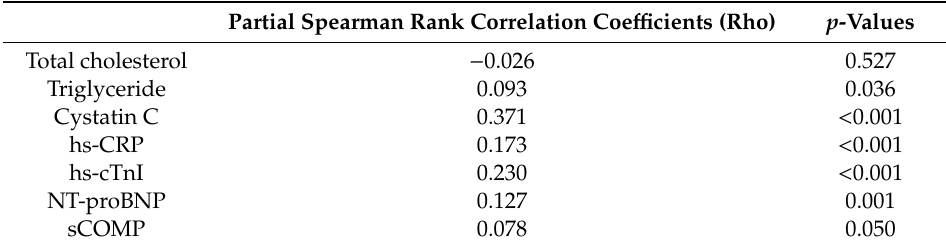
Table 2. Correlation between GDF-15 and several biochemical parameters, adjusted for age and sex. Partial Spearman Rank Correlation Coe ffi cients (Rho) p -Values Total cholesterol 0.026 0.527 − Triglyceride 0.093 0.036 Cystatin C 0.371 < 0.001 hs-CRP 0.173 < 0.001 hs-cTnI 0.230 < 0.001 NT-proBNP 0.127 0.001 sCOMP 0.078